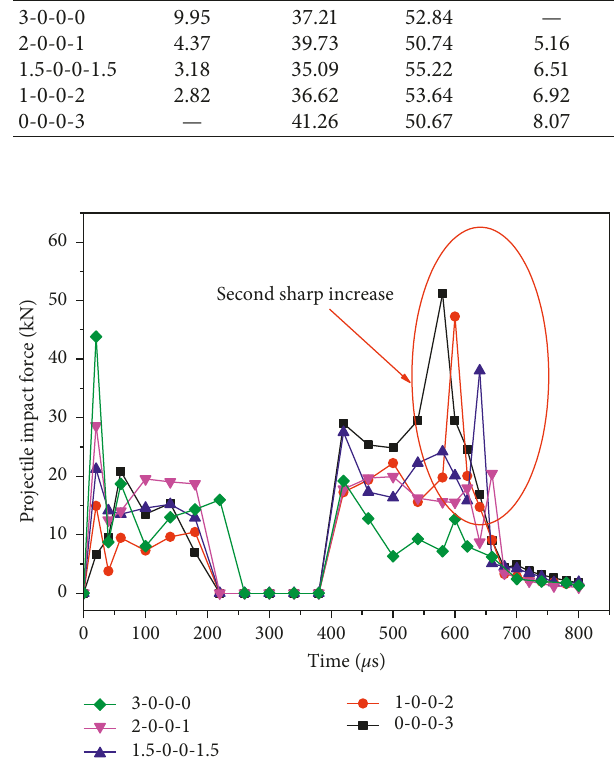
Figure 19: Impact force-time curves of projectile perforating segmented targets with different steel liner layouts.